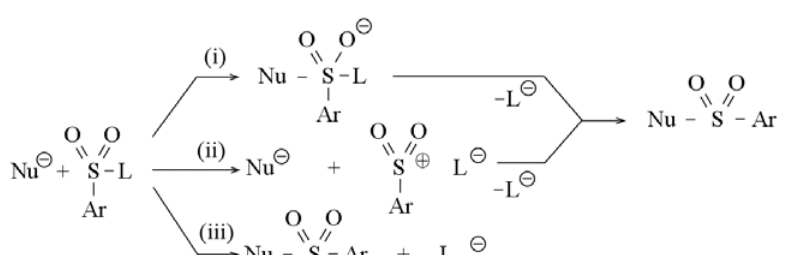
Scheme 3. Sulfonyl transfer reactions of aryl arenesulfonates (L:OAr) and aryl sulfonyl halides (L:halogen) with nucleophiles.(i) S elimination) mechanism, (ii) S